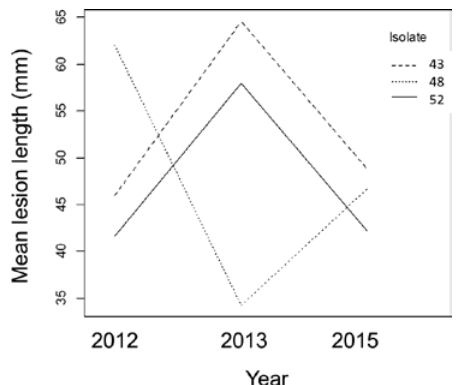
Figure 9. Mean lesion lengths (mm): trends between years (2012, 2013 or 2015) and Phaeomoniella chlamydospora isolates (43, 48 and 52).